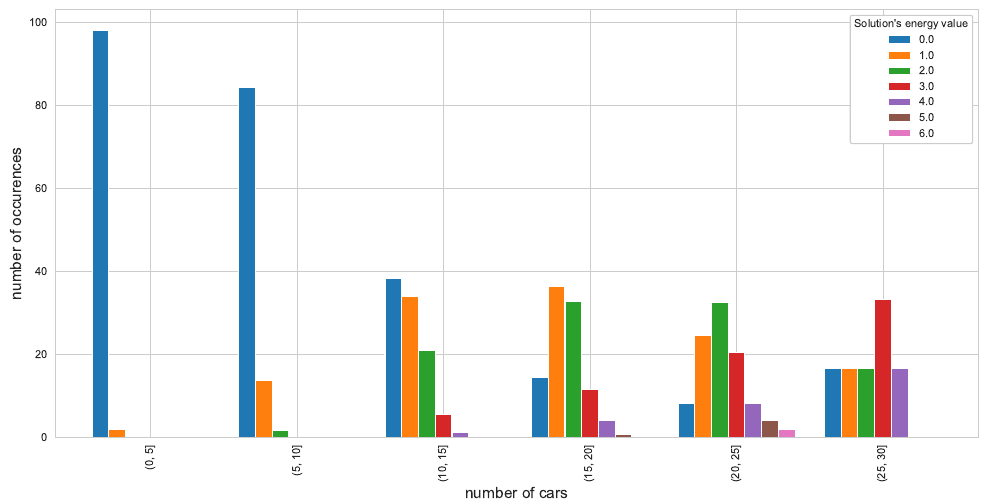
Figure 9. The quality of quantum-annealing-based solutions to the conflict-free EMV charging problem with respect to the number of EMVs in the problem instance. Different colors represent different number of unresolved collisions occurring in the